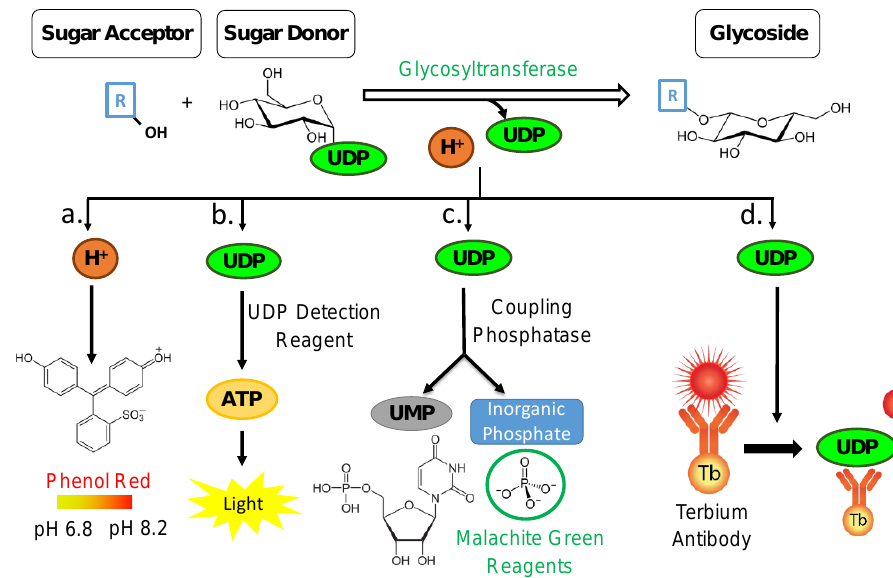
Figure 1. Glycosyltransferase reaction mechanism resulting in the formation of a glycoside. The quantity of by-products is detected by four different assays prone to be high-throughput (HTP). ( a ) Colorimetric pH-sensitive assay—the relationship between the amount of glycoside formed to the pH value is inversely proportional. ( b ) UDP-Glo TM assay—UDP is converted to ATP which triggers a luciferase reaction and generates light. The relationship between the amount of glycoside formed to the amount of ATP detected is directly proportional. ( c ) Phosphate GT assay—a 2-step colorimetric assay utilizing phosphatase and malachite green reagents. The relationship between the amount of glycoside formed to the formation of phosphate is directly proportional. ( d ) UDP 2 TR-FRET immunoassay—a competitive immunoassay for UDP with a far-red, TR-FRET readout. The relationship between the amount of glycoside formed to the FRET signal is inversely